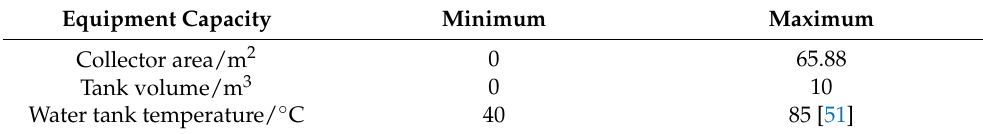
Table 1. Parameter